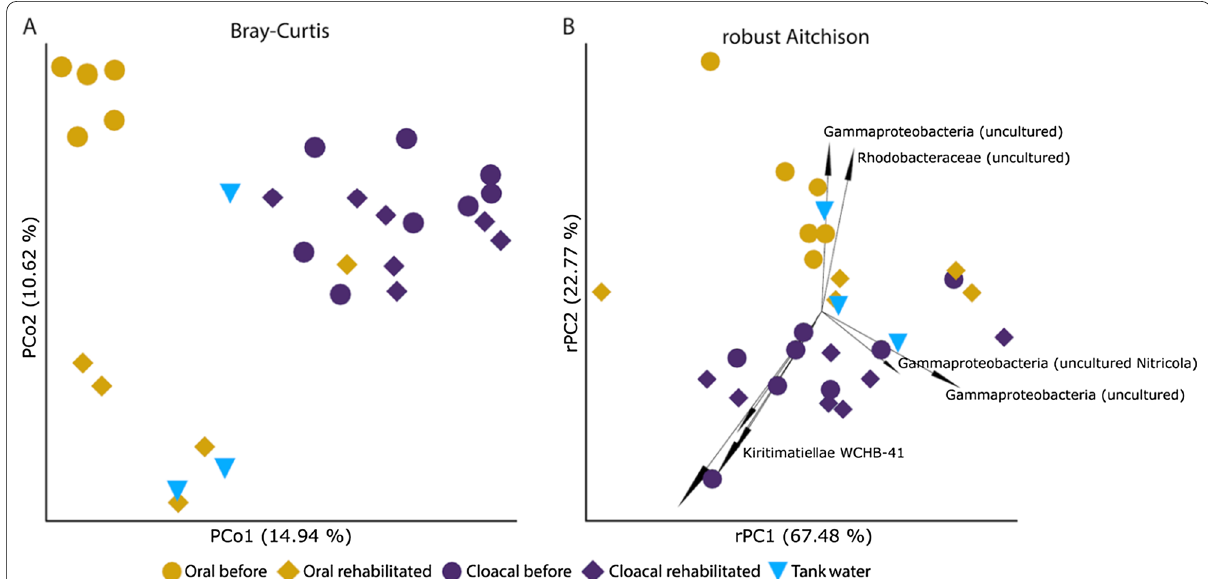
Fig. 2 Comparison of microbial diversity in loggerhead cloacal, oral and tank water samples a principal coordinate analysis (PCoA) plot of Bray– Curtis distances and b principal component analysis (PCA) biplot of robust Aitchison distances with loadings as individual highly ranked ASVs